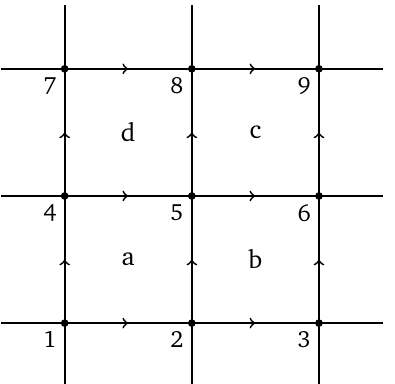
Figure 36: For each face, there are two Majorana fermions γ there is a qubit, corresponding to the Pauli matrices X